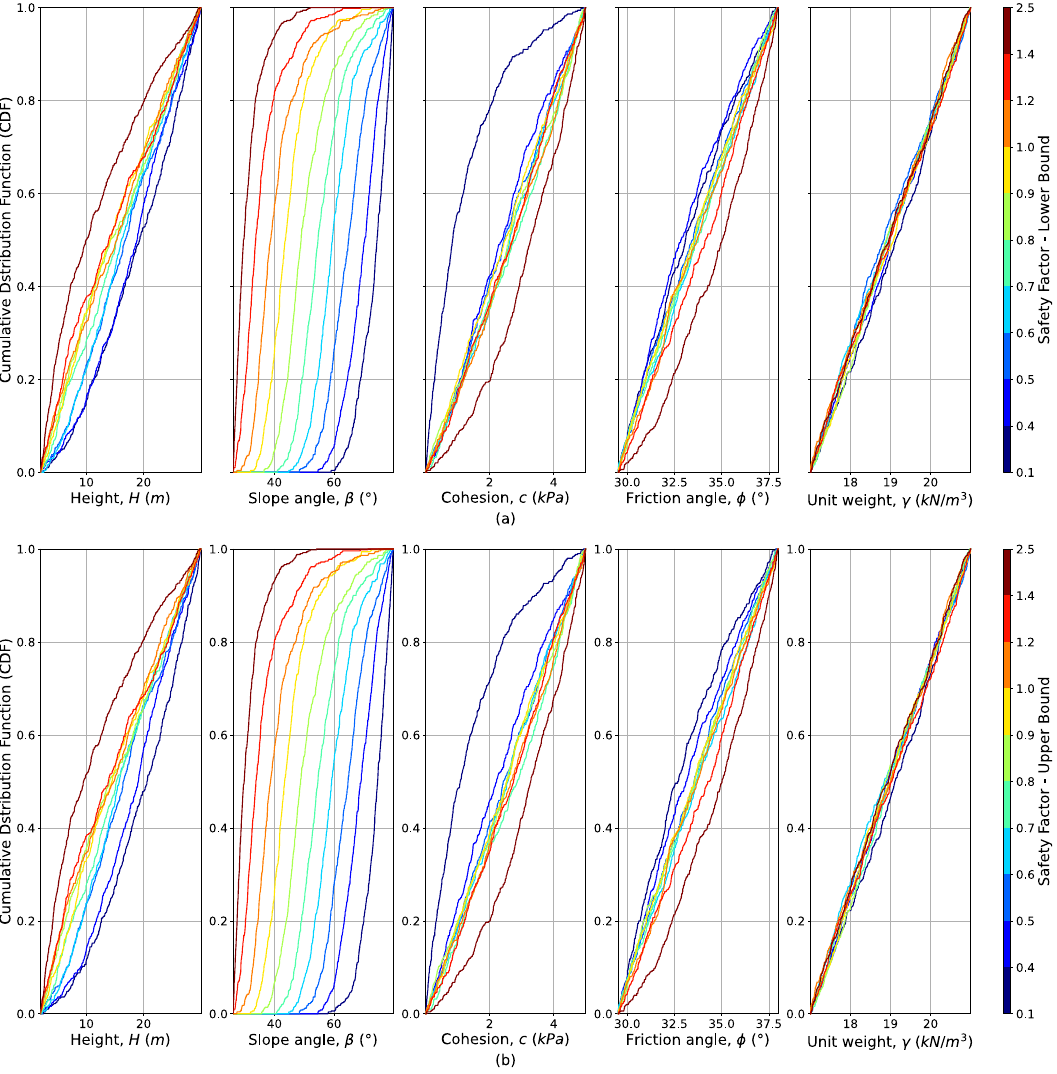
Figure 5. Cumulative distribution function by deciles of model behavior for ( a ) lower bound (SF-LB) and ( b ) upper bound (SF-UB).